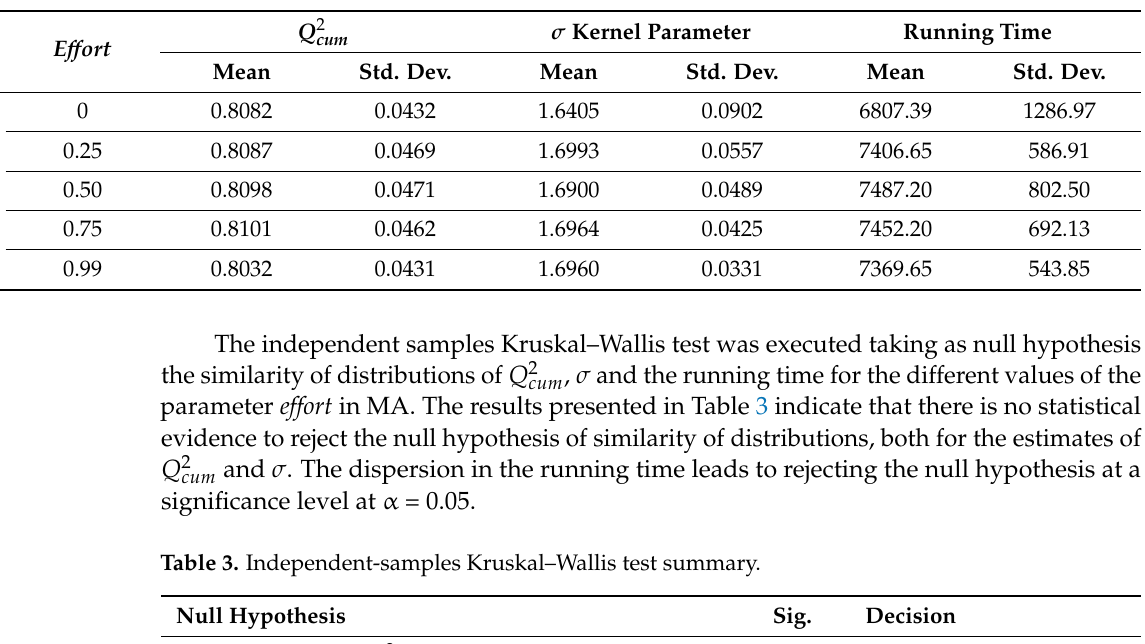
Table 2. Mean and standard deviation of Q 2 cum , σ and running time estimates.